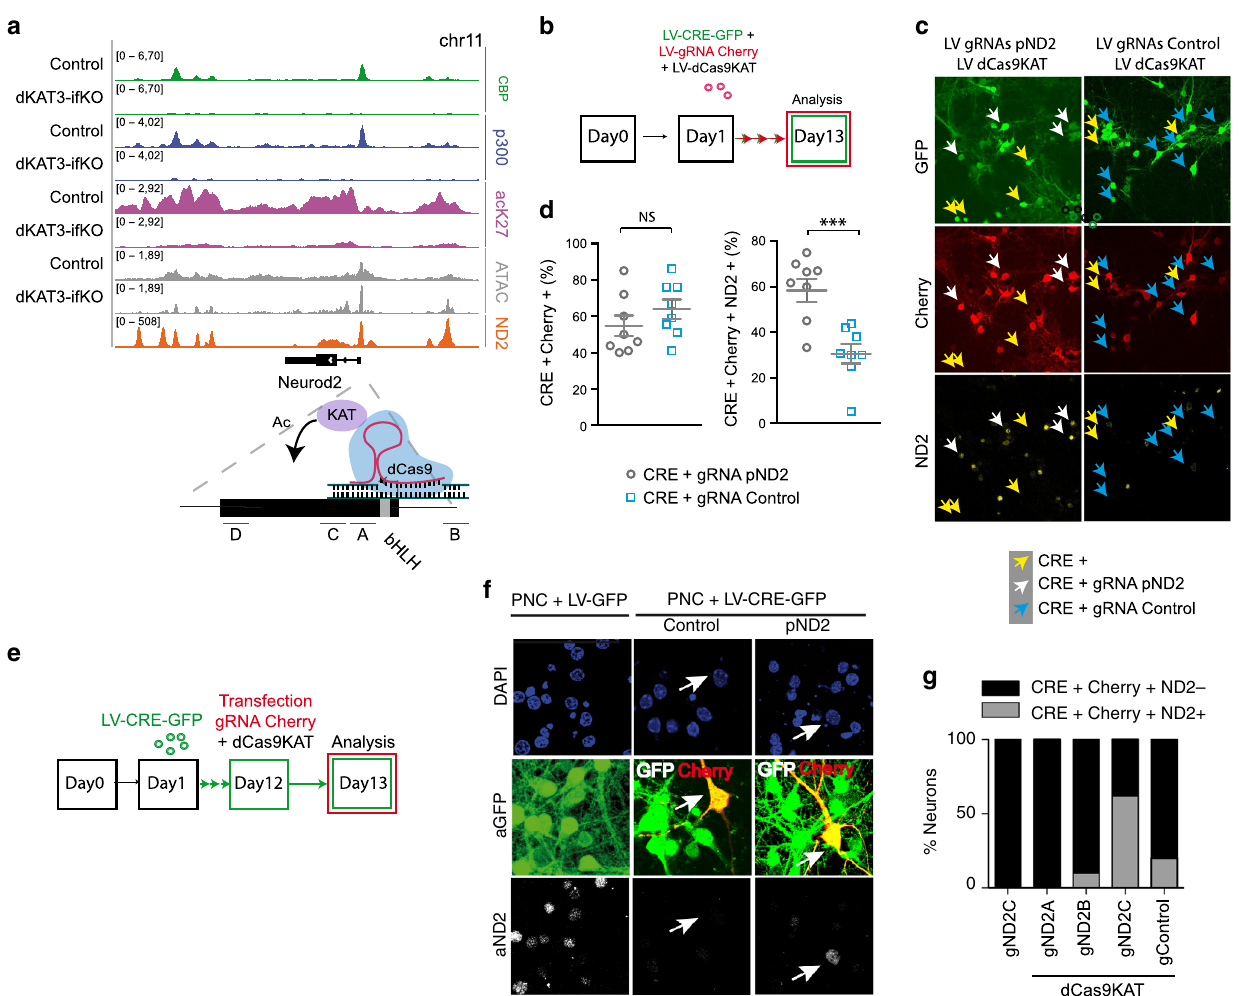
Fig. 8 Locus-speci fi c acetylation restores NeuroD2 transcription. a Snap view of the Neurod2 locus. The pro fi les for CBP and p300 binding, H3K27 acetylation and ATAC-seq signal are shown. The bottom orange track corresponds to the NeuroD2 ChIP-seq data generated in ref. 29 . A scheme presenting the strategy used to drive the KAT activity of p300 to the Neurod2 promoter using a fusion protein with dCas9 is also shown. The positions targeted by the gRNAs (red lines, gND2 A-D) are indicated. Note that the target regions are in the proximity of bHLH sites. b Scheme of the co-infection of LVs expressing cre recombinase, dCas9-KAT, and the Neurod2 gRNAs (A-D mix). c Representative image of NeuroD2 protein levels in the cells co- infected with LV-CRE-GFP and the lentiviruses LV-gRNA-mCherry speci fi c for Neurod2 (white arrows). As a speci fi city control, we conducted the same experiment using a gRNA targeted to Hpca (blue arrows) ( n = 4 wells per condition in 2 PNCs). As a comparison, cells infected with LV-CRE-GFP alone (yellow arrows) show strongly diminished NeuroD2 levels as well. Scale bar: 50 μ m. d Quanti fi cation of different cell subpopulations observed in the experiment shown in panel ( c ) ( n = 4 wells per condition in 2 PNCs). Two-tailed t -test: **** p < 0.0001, *** p < 0.001, ** p < 0.01; * p < 0.05. Data are presented as mean values ± SEM. e Scheme of rescue experiment with plasmids carrying dCas9-KAT and the Neurod2 gRNA in dKAT3-KO cells that had already lost Neurod2 expression. f Representative image of NeuroD2 expression in control (PNC + LV-GFP) and dKAT3-depleted (PNC + LV-CRE-GFP) neurons after transfection with dCas9-KAT and gND2-C targeting the NeuroD2 promoter. Arrows indicate LV-CRE-GFP infected cells transfected with the gRNA-carrying vector. A gRNA targeting the hippocalcin promoter was used as a speci fi city control. Scale: 20 μ m. g Quanti fi cation of the percentage of transfected cells showing normal NeuroD2 expression after transfection with gND2-C alone and dCas9-KAT co-transfected with gND2-C, gND2-A, gND2- B, or gRNA control independently (experiments in three independent PNCs; n = 30 – 40 neurons per condition). Source data for graphs in panels ( d ) and ( g ) are provided as a Source data fi